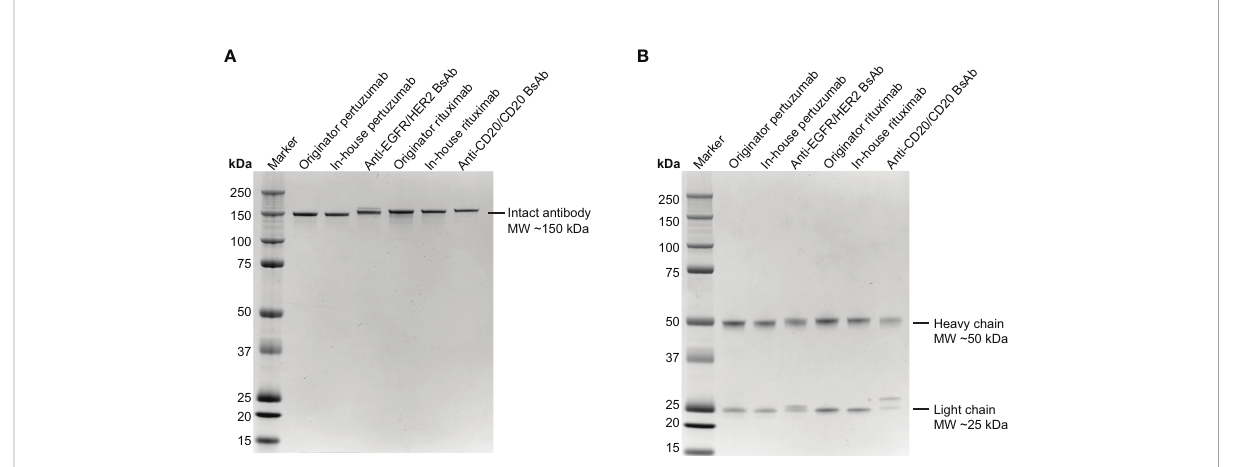
FIGURE 3 SDS-PAGE analysis of the two BsAbs compared to parental mAbs. Puri fi ed pertuzumab, anti-EGFR/HER2 BsAb, rituximab and anti-CD20/CD20 BsAb were subjected to electrophoresis in 4-12% SDS PAGE under (A) nonreducing condition and (B) reducing condition then stained with Coomassie Blue. Precision Plus Protein Kaleidoscope Prestained Protein Standards (Bio-Rad) was used as molecular weight